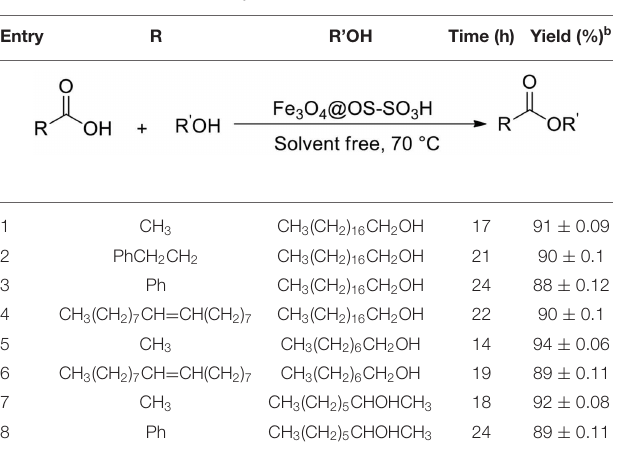
TABLE 2 | The esterification of carboxylic acids with alcohols in the presence of the Fe 3 O 4 @OS-SO 3 H nanocatalyst a .